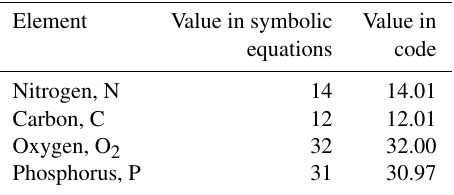
Table 41. Atomic mass of the C, N, P and O 2 , both in the model description where two significant figures are used for brevity and in the numerical code, where precision is more